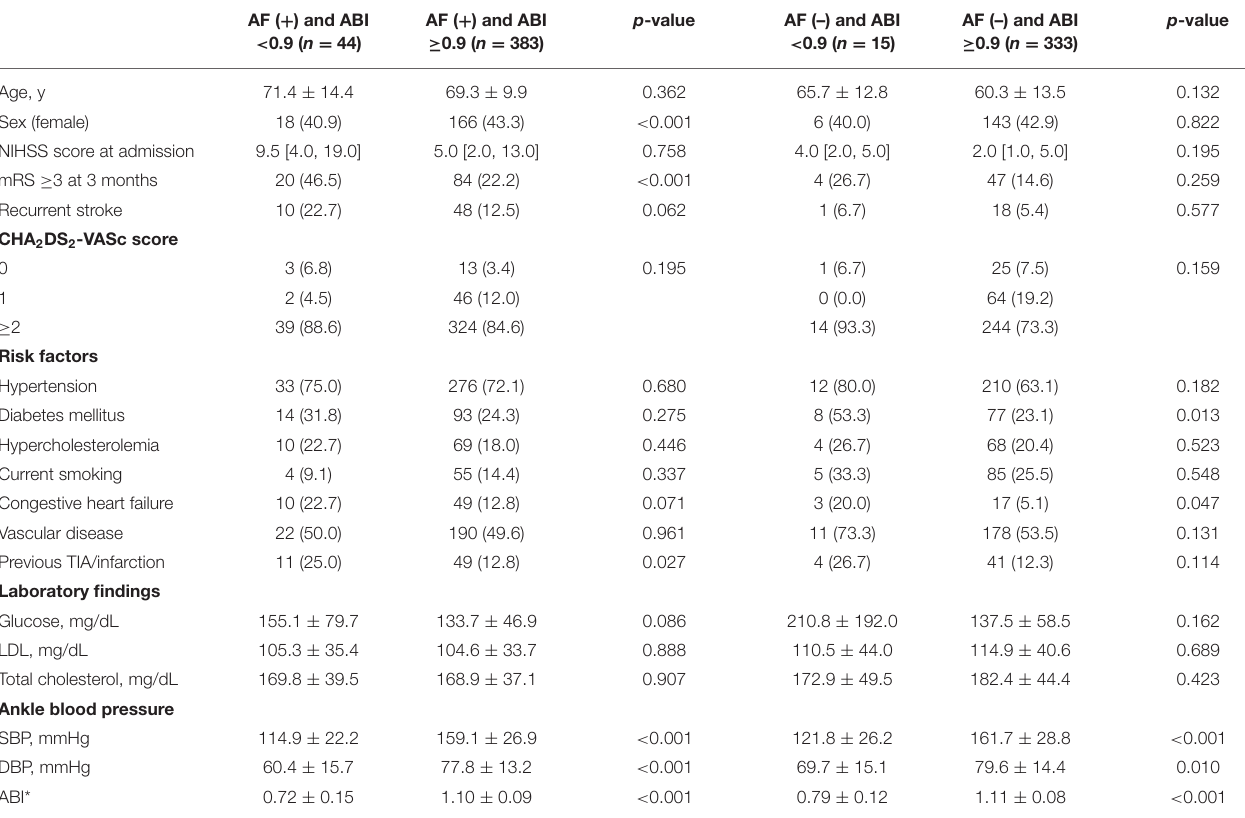
TABLE 1 | Patient demographics and clinical characteristics according to AF and an ABI < 0.9.